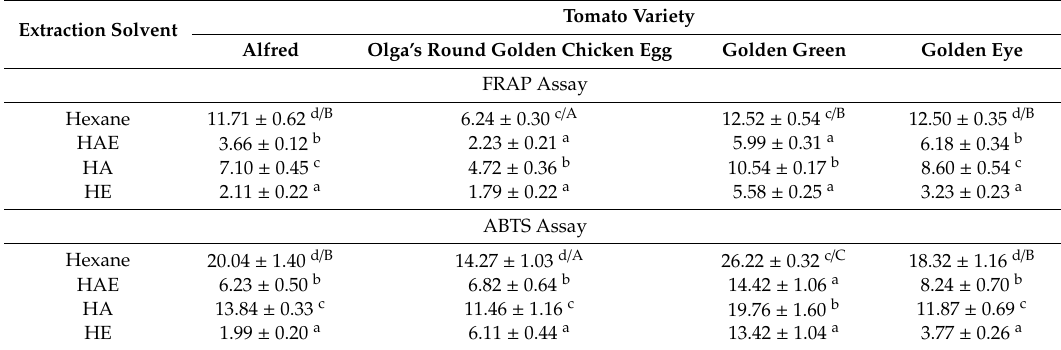
Table 2. Antioxidant activity of tomato extracts as assessed through the FRAP and ABTS assays. Extraction